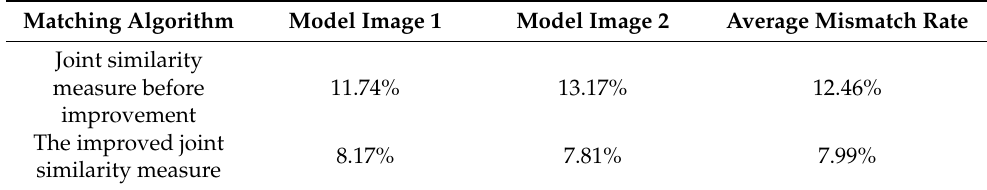
Figure 6. Two adaptive weight methods correspond to the matching results. ( a ) Left map of heart model; ( b ) standard disparity map; ( c ) disparity map corresponding to adaptive weight before improvement; ( d ) disparity map corresponding to adaptive weight after improvement. Comparing